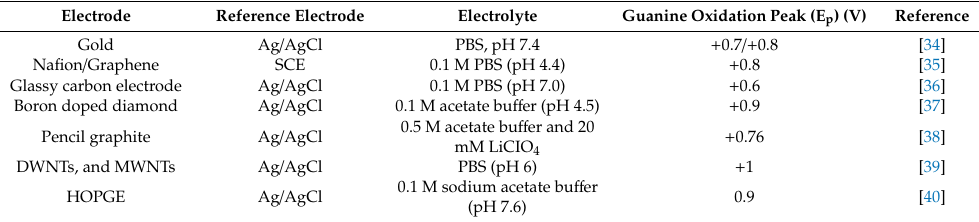
Table 1. Direct oxidation of DNA oxidation of guanine on di ff erent electrode supports. Electrode Reference Electrode Electrolyte GuanineOxidationPeak(E p